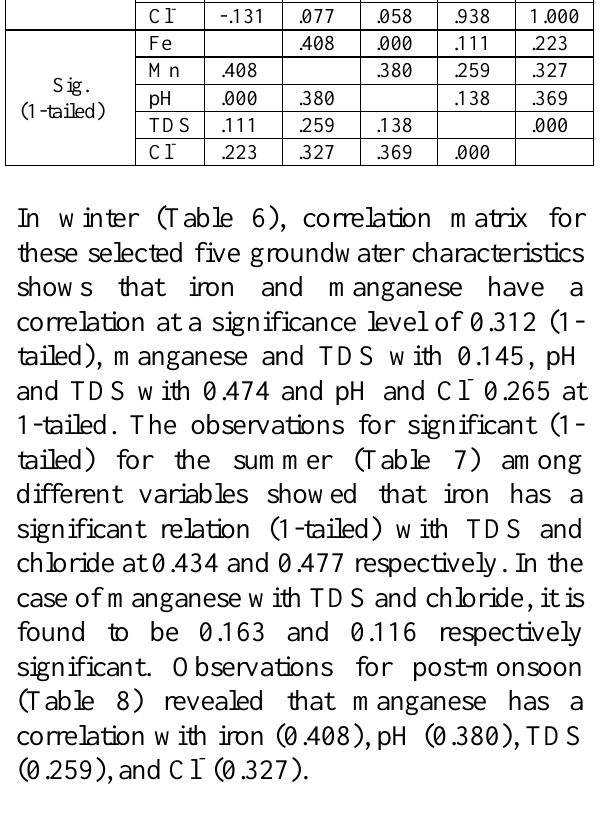
Table 6. Correlation matrix (winter)